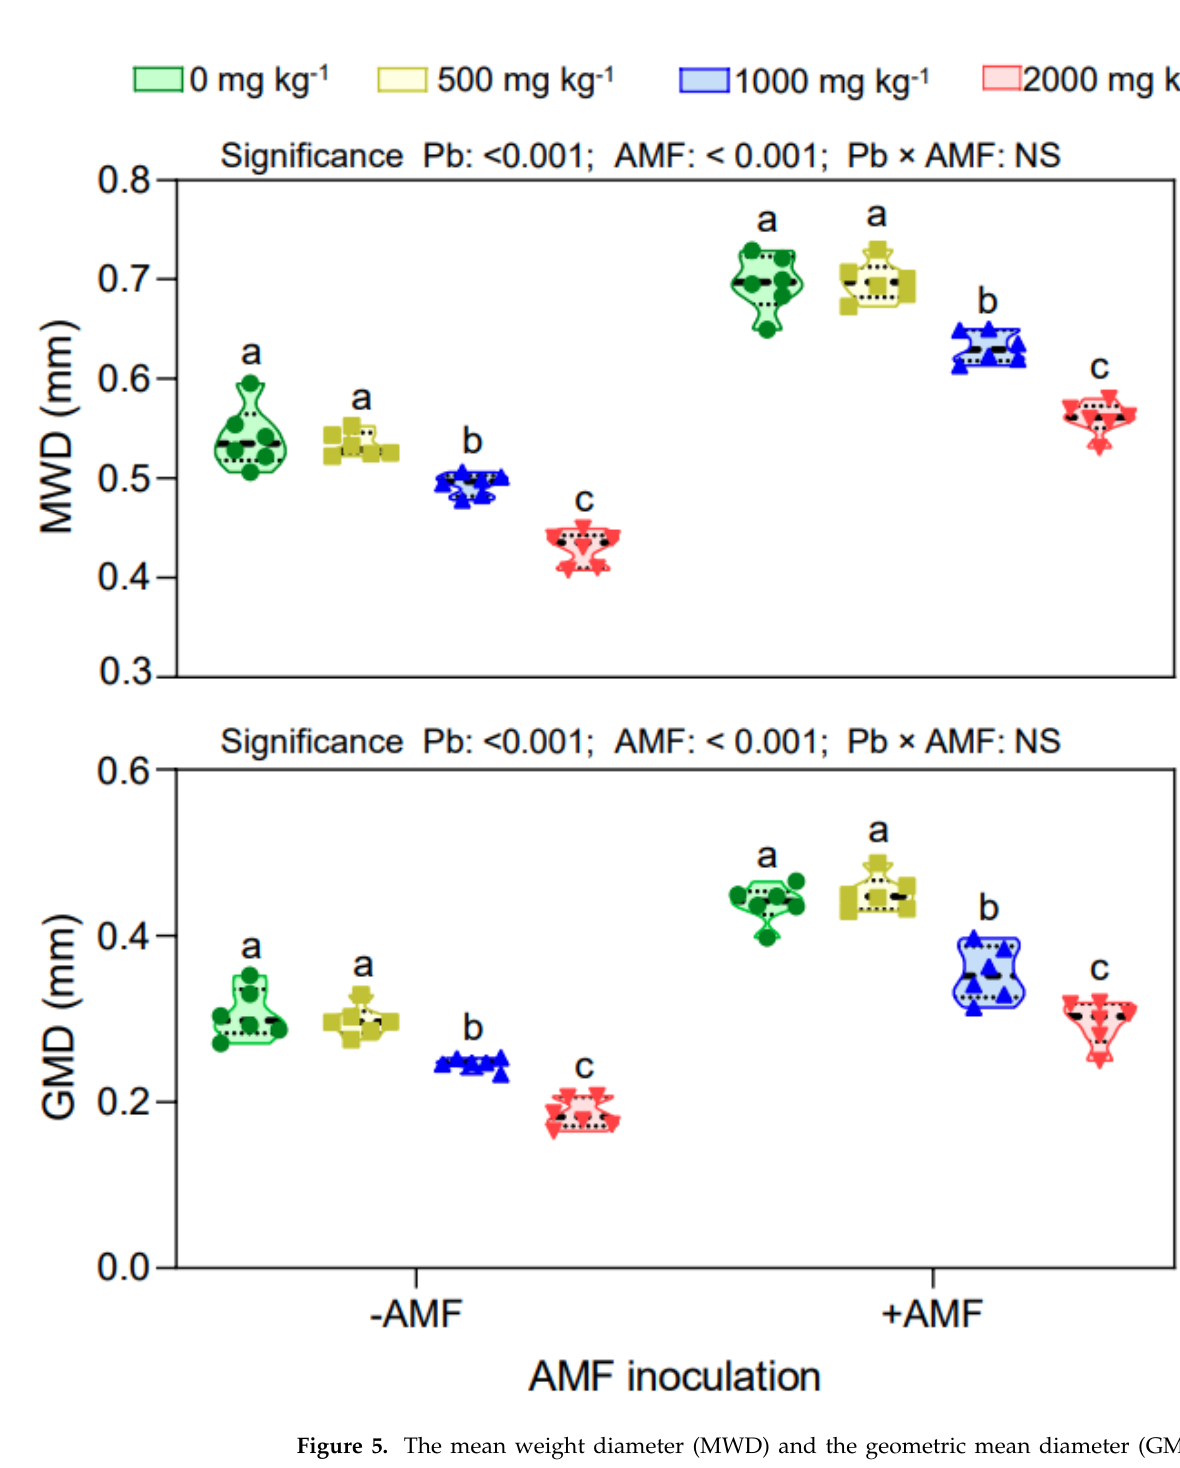
Figure 5. The mean weight diameter (MWD) and the geometric mean diameter (GMD) under different treatments. Non–AMF inoculation ( − AMF); AMF inoculation (+AMF); Pb stress level (0, 500, 1000, and 2000 mg kg − 1 ). Data represent mean ± SD for biological replicates ( n = 6). The same letter indicates no significant difference (Duncan’s test, p < 0.05).